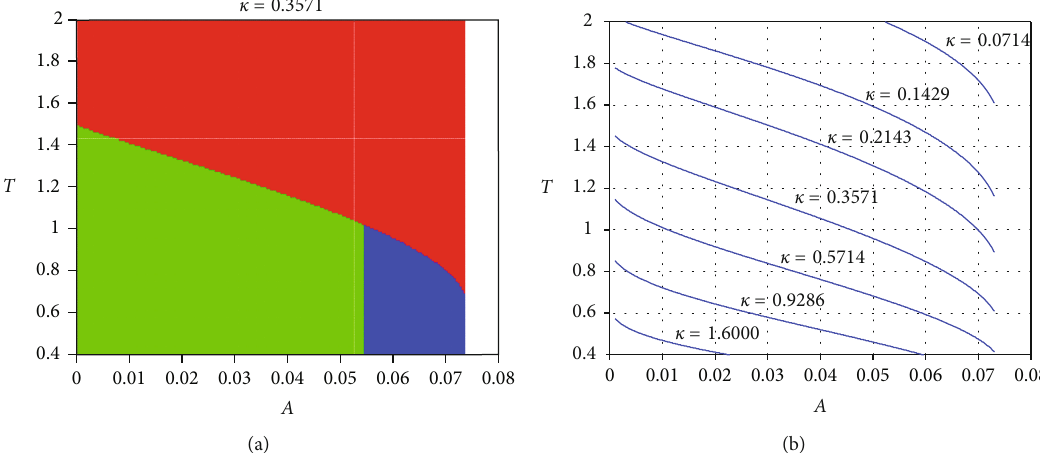
Figure 5: (a) Areas in the plane A and T where the conditions for the existence are satis fi ed (blue) and where they are not (red) with κ = 0 : 3674 . (b) Boundary between satisfying and not satisfying the conditions of Theorem 7 for di ff erent values of κ